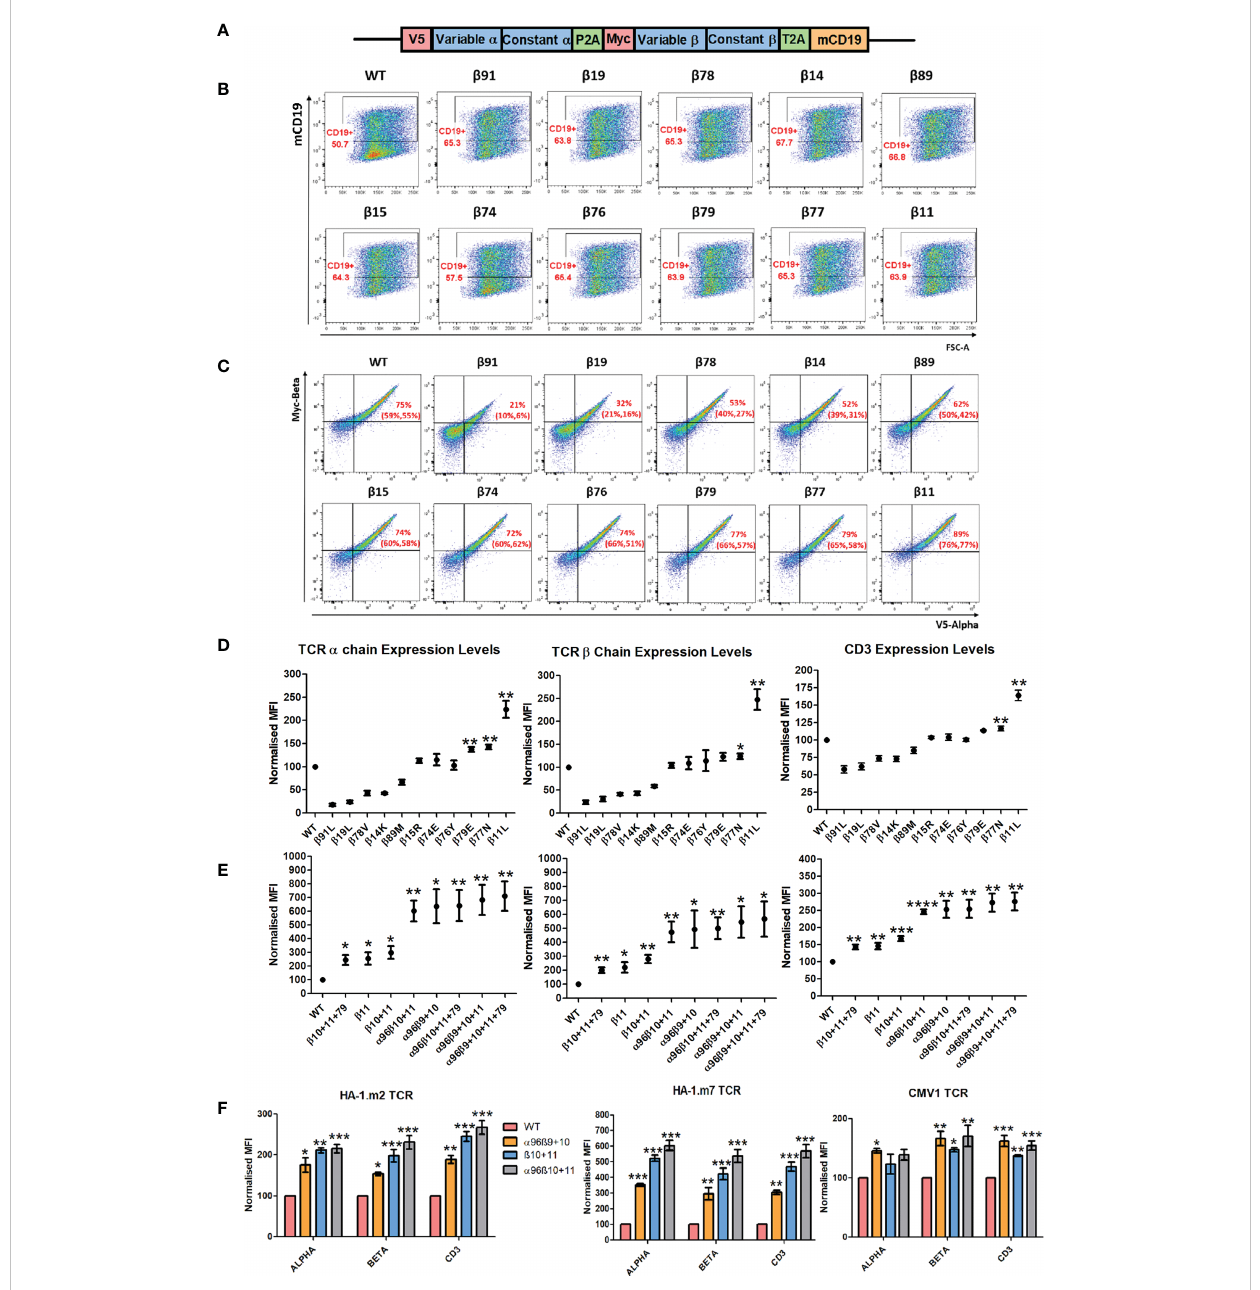
FIGURE 2 Single and combinations of amino-acid TRBV framework residue replacements can improve TCR expression in Jurkat76 cells. (A) Schematic representation of the retroviral vector that was used to transfer TCRs into Jurkat76 and primary T cells. Anti-V5 and anti-Myc Abs were used to determine the expression levels of TCR a and TCR b respectively. Anti-murine CD19 Abs were used to determine transduction ef fi ciency. mCD19 truncated murine CD19 sequence. (B) Representative example of three independent experiments showing Jurkat76 cells transduced with either the weak1 wild-type (WT) TCR or weak TCR constructs with the indicated single TCR b chain amino-acid residue swap. Shown is mCD19 expression levels, indicating transduction ef fi ciency. (C) Representative plots of three independent experiments showing TCR a and TCR b expression in CD19+ gated Jurkat76 cells expressing WT or single amino-acid TCR b chain residue modi fi ed versions of the Weak1 TCR. Numbers in brackets demonstrate the percentage of introduced TCR+ cells of the repeated experiments (D) Representative graphs of three independent experiments showing MFI (median fl uorescence intensity) of TCR a , TCR b and CD3 expression in CD19+ gated Jurkat76 cells transduced with WT or single amino-acid TCR b versions of the weak1 TCR. MFI (Mean+/- SEM) data has been normalised to WT expression. Unpaired t test was applied, *: p<0.05, **: p<0.01 (E) Representative graphs of three independent experiments showing MFI of TCR a , TCR b and CD3 expression in CD19+ gated Jurkat76 cells transduced with either weak1 WT TCR or TCRs with either 1 amino-acid TCR b chain residue change, or residue combinations as indicated. MFI (Mean+/- SEM) data has been normalised to the WT TCR expression. Unpaired t test was applied, *: p<0.05, **: p<0.01 (F) Jurkat76 cells were transduced with either WT TCRs or 3 TCR versions with the indicated residue modi fi cations for 3 different antigen speci fi c TCRs (HA1.m2, HA1.m7 and CMV1 pp65). Shown is a representative example of three independent experiments showing MFI values of TCR a , TCR b and CD3 in CD19+ gated cells. MFI (Mean+/- SEM) data has been normalised to WT expression. One-way ANOVA, Dunnett ’ s Multiple Comparison Test, *: p<0.05, **: p<0.01, ***: p<0.001 (Residue changes were as followed: HA1.m2: a 96P>L, b 10H>Y, b 11K>L, HA1.m7: a 96T>L, b 10H>Y, b